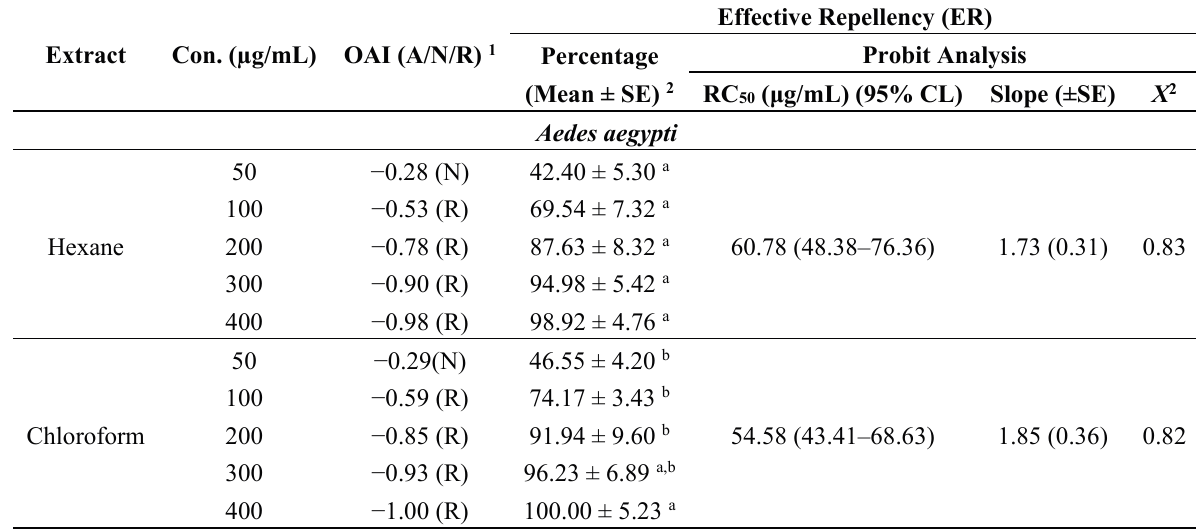
Table 5. Oviposition activity of Bryopsis pennata extracts against Aedes aegypti and Aedes albopictus